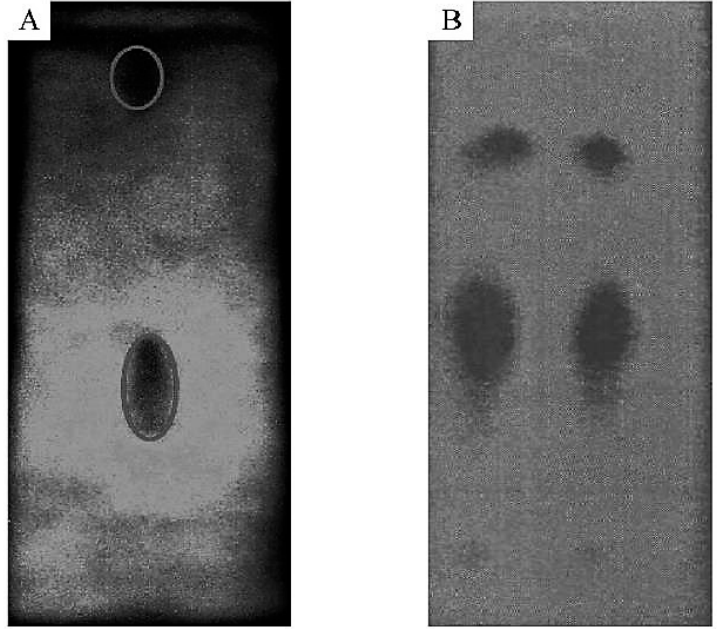
Figure 4. The effect of MWCNTs-HP- β -CD on the resolution of clenbuterol in TLC “Reproduced with permission from Yu et al. [59]. Copyright Wiley, 2011”. Resolution of clenbuterol by using ( A ) MWCNTs-HP- β -CD in TLC ( B ) HP- β -CD without MWCNTs in TLC. This was done at room temerature and with 10 mL of acetonitrile/ t -butanol ( v : v = 1:1) as a mobile phase.